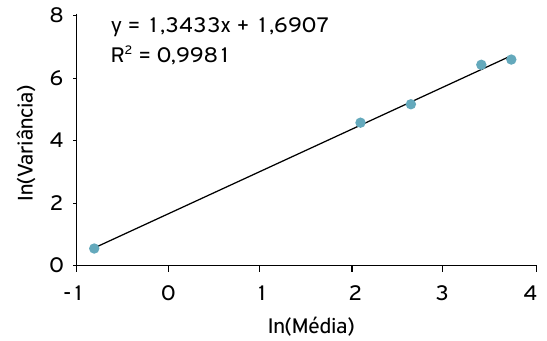
Figura 1. Linearização da Lei de Potência de Taylor (s 2 = a + m^ .b) para estudo de agregação de ataque de Heilipodus naevulus (Mannerheim, 1836) utilizando-se ln S 2 = ln a + b ln m^ , Antilog a = 5,4233. Barão de Cocais